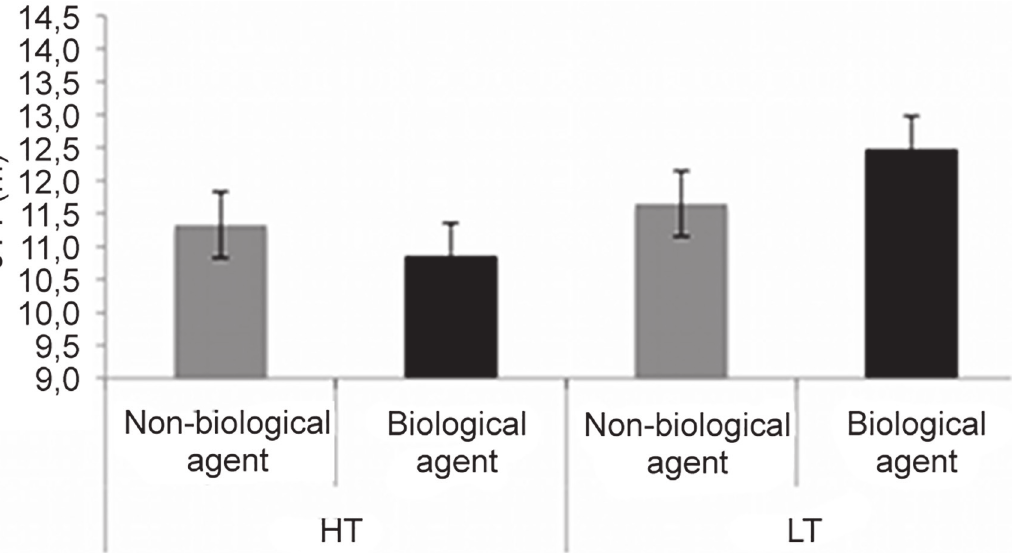
Fig 3. Mean judgment transition threshold (JTT) in LT and HT groups in the two RF types (Biological and Non-biological agent).